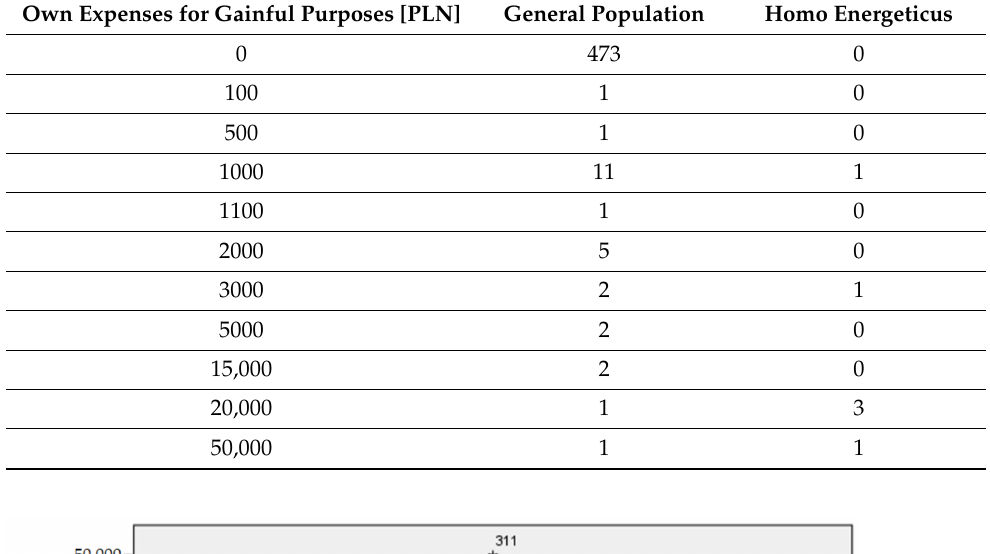
Table 6. The volume of own expenses: the comparison of responses from the entire studied population and homo energeticus.